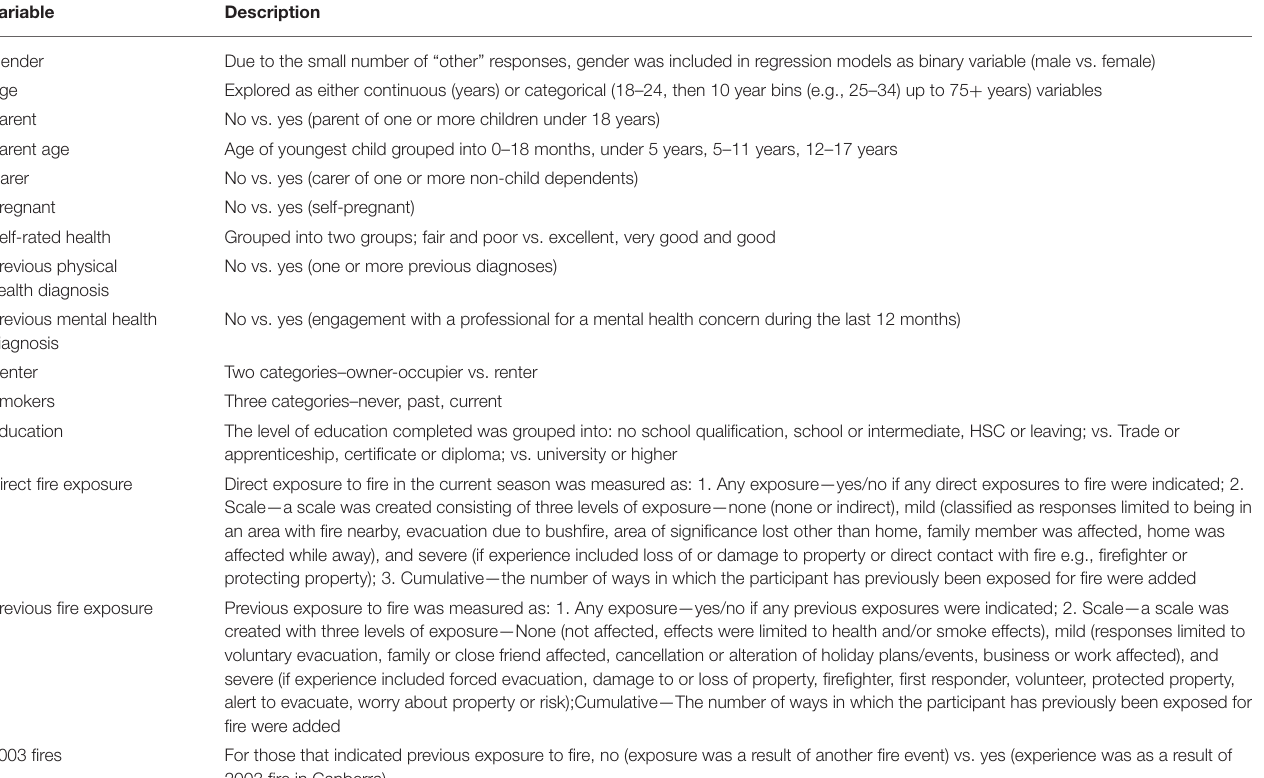
TABLE 2 | Details of variables used to describe the study population in regression models.